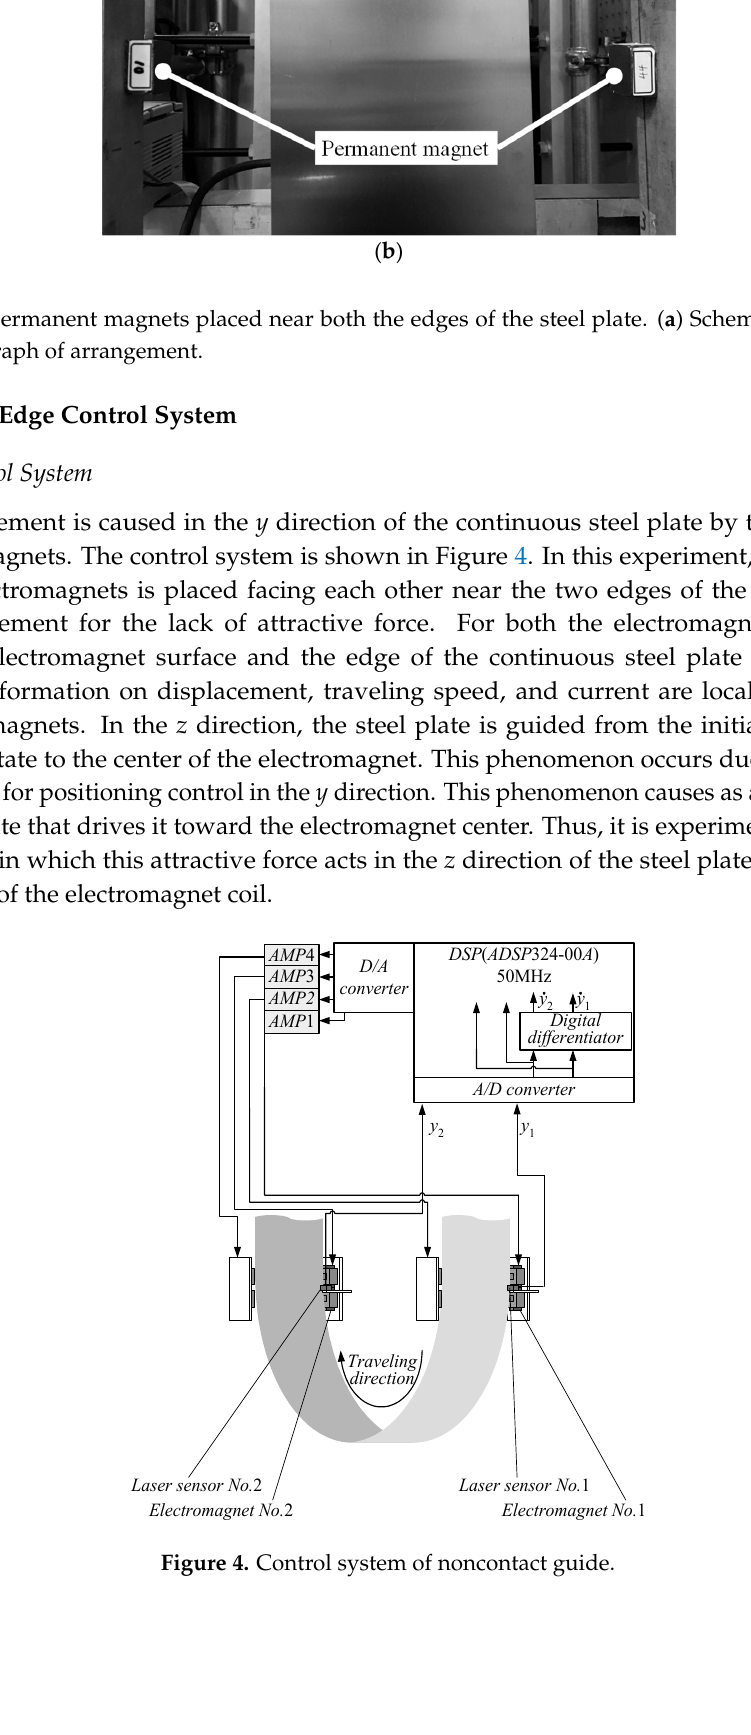
Figure 4. Control system of noncontact guide.